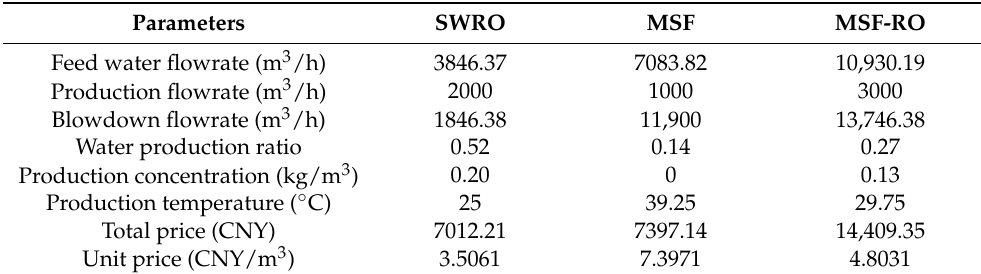
Table 10. Overall water production in option